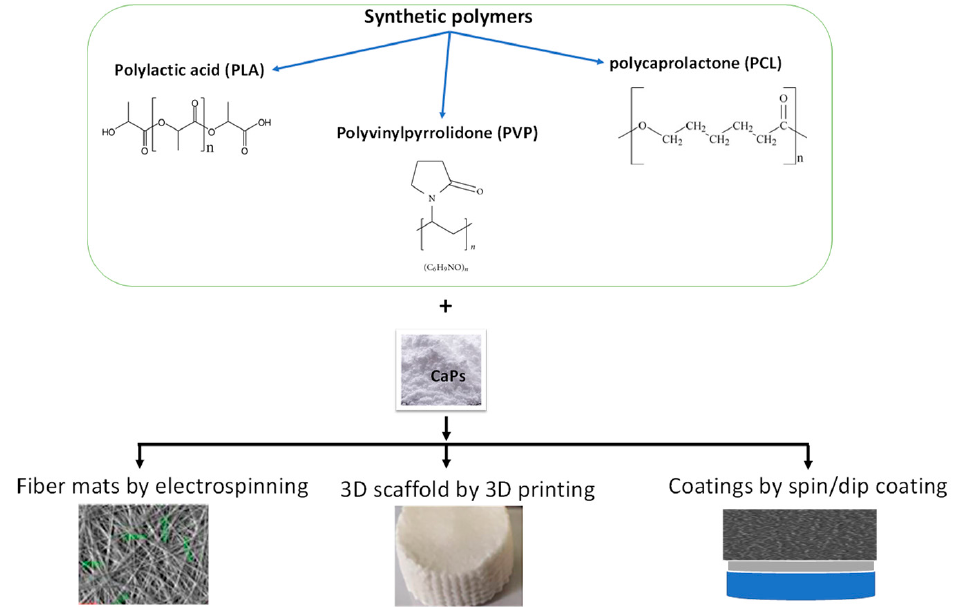
Figure 3. Graphical illustration of the most frequently used synthetic polymers that can be used as CaP-containing composites, their possible application forms, and preparation methods.